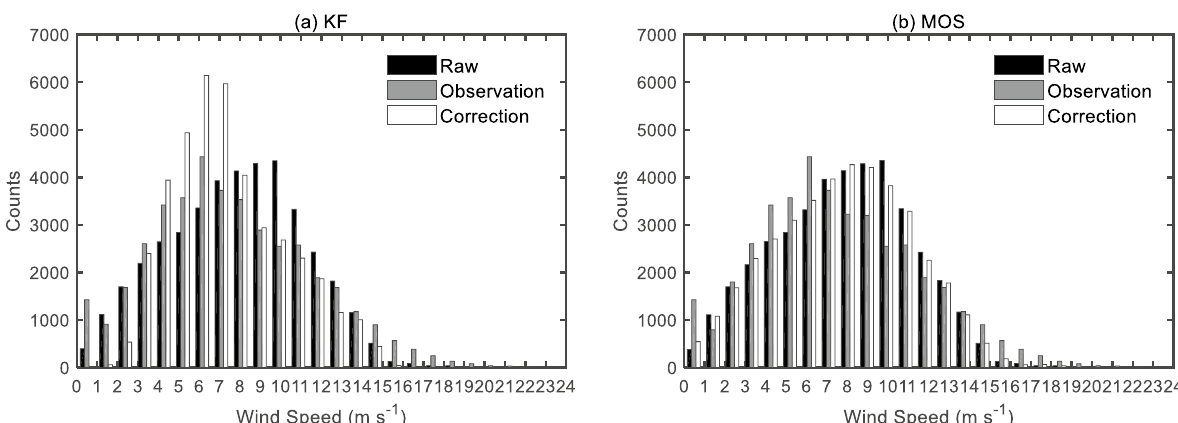
Fig. 5 The wind speed distribution of the observation, the raw forecasts and the a KF, b MOS